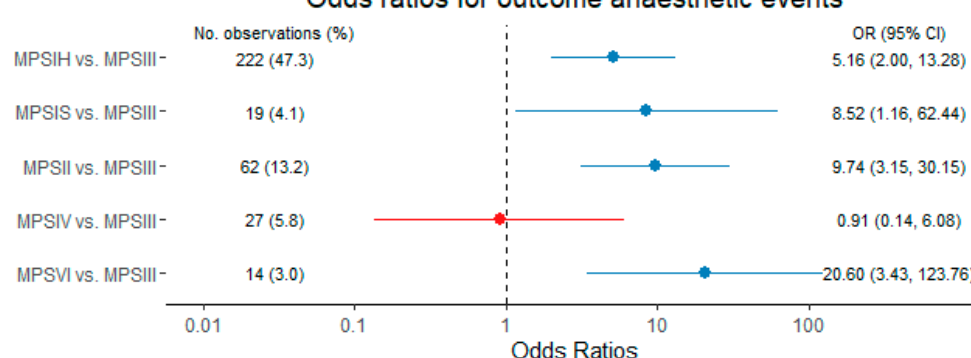
Figure 4. Estimated odds ratios and 95% confidence intervals (CI) for anaesthesia-related complica- tions from a multivariable model based on disease subtypes. Variables are presented in blue color (increased risk) or red color (decreased risk), respectively. Abbreviations: CI, confidence interval; MPS, mucopolysaccharidosis.